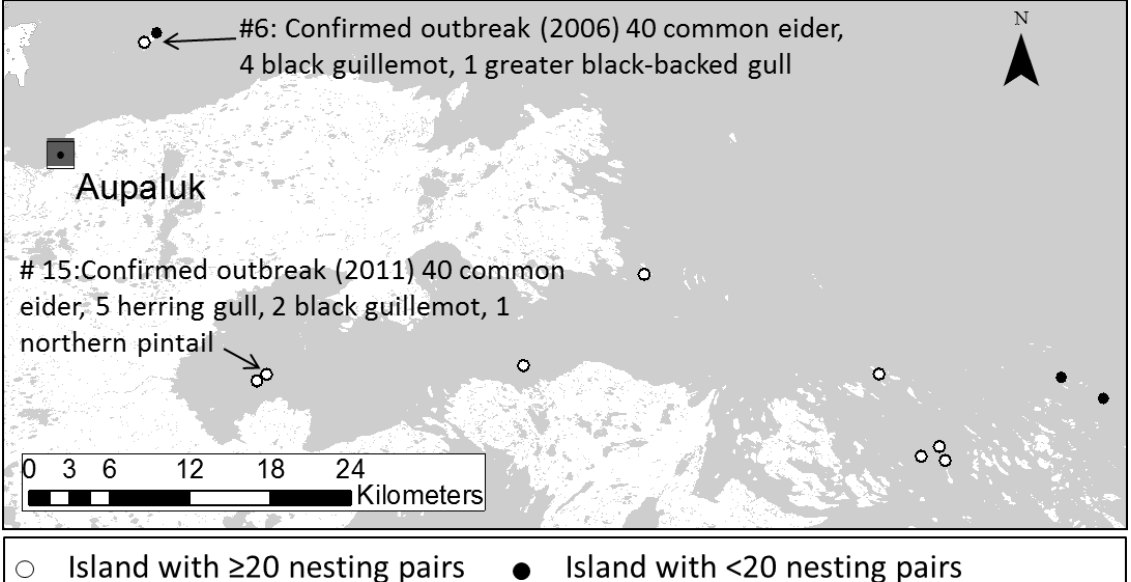
Figure A1.1 Survey zone 1: Ikkatuk Bay, Western Ungava Bay